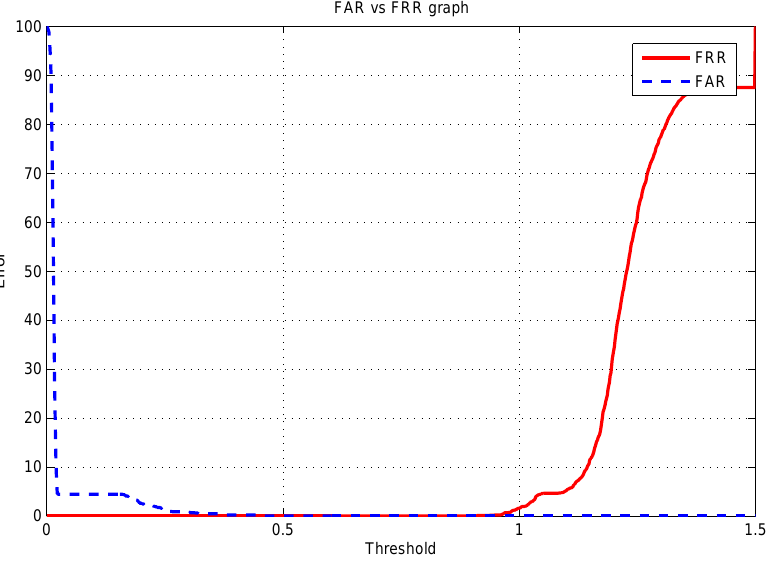
Figure 4. The EER of the proposed multimodal cancelable